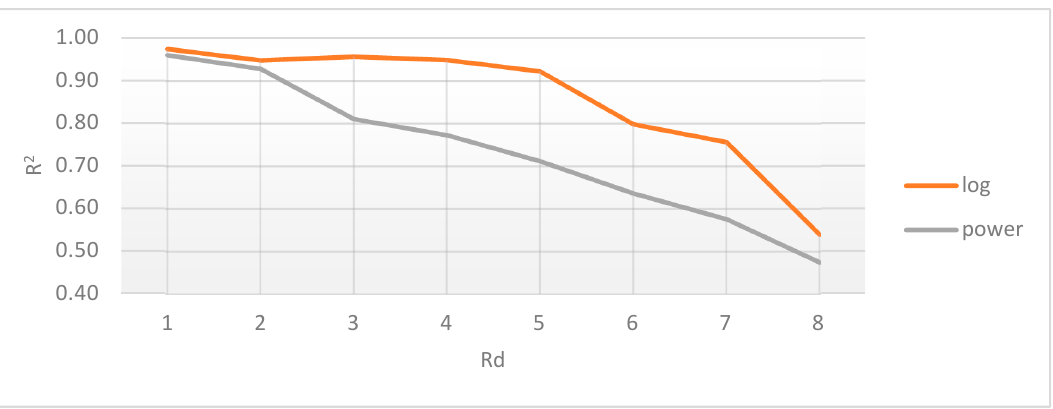
Figure 10. Average coefficient of determination (R 2 ) for logarithmic and power distributions, relative to radial distance (Rd).